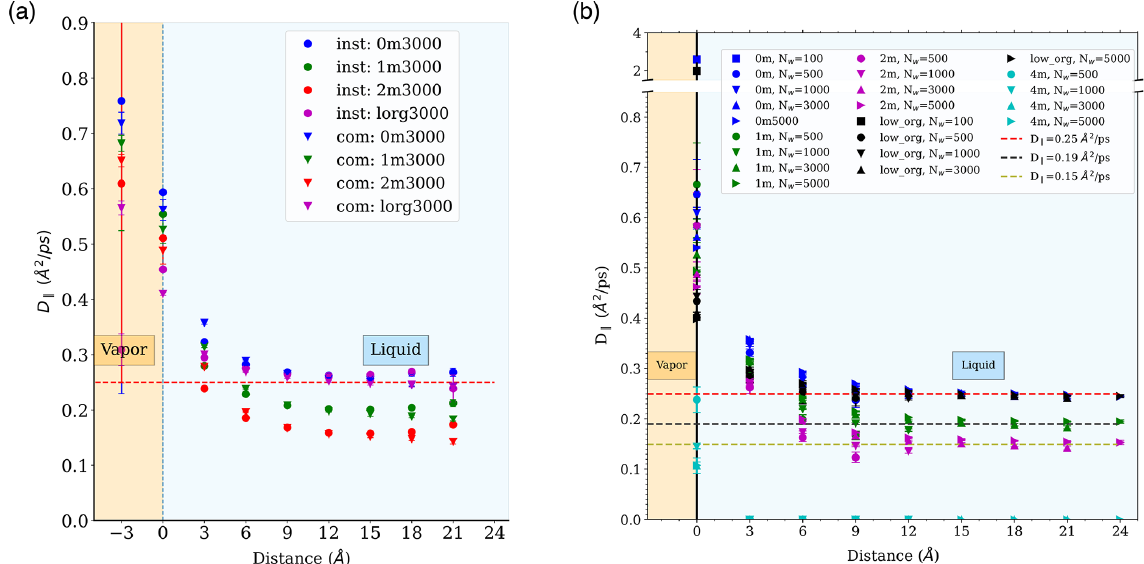
Figure A8. Water diffusion coefficient in the direction parallel to the interface, as a function of distance from the interface: (a) under the center of mass (com) and the instantaneous interface (inst) schemes for droplets containing 3000 water molecules with salinity of 0, 1, and